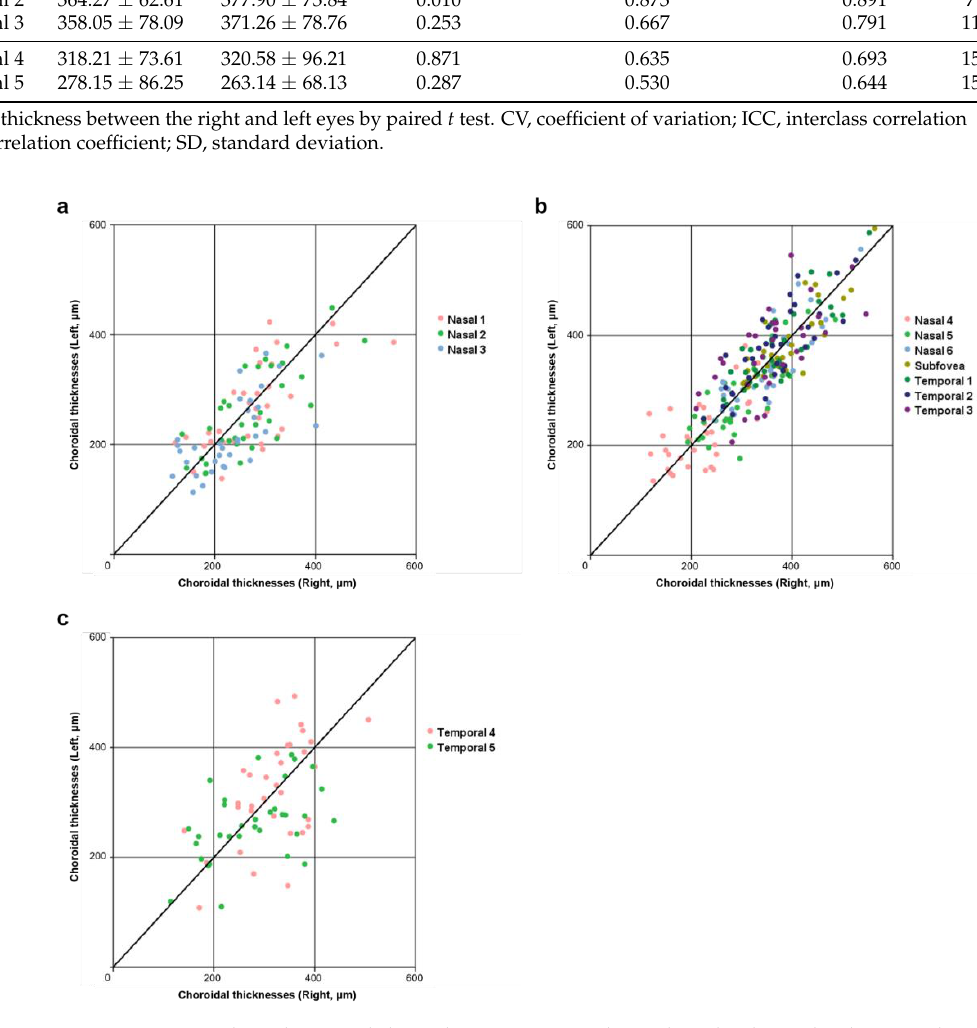
Figure 2. Scatter plots showing bilateral CT in uncomplicated pachychoroid subject in the nasal peripapillary ( a ), macular ( b ), and peripheral ( c ) areas. In the nasal peripapillary area ( a ), the scatter plot indicates weaker correlations than in the macular area ( b ), but stronger correlations than in the peripheral area ( c ) between right and left eye CT. CT, choroidal thickness.